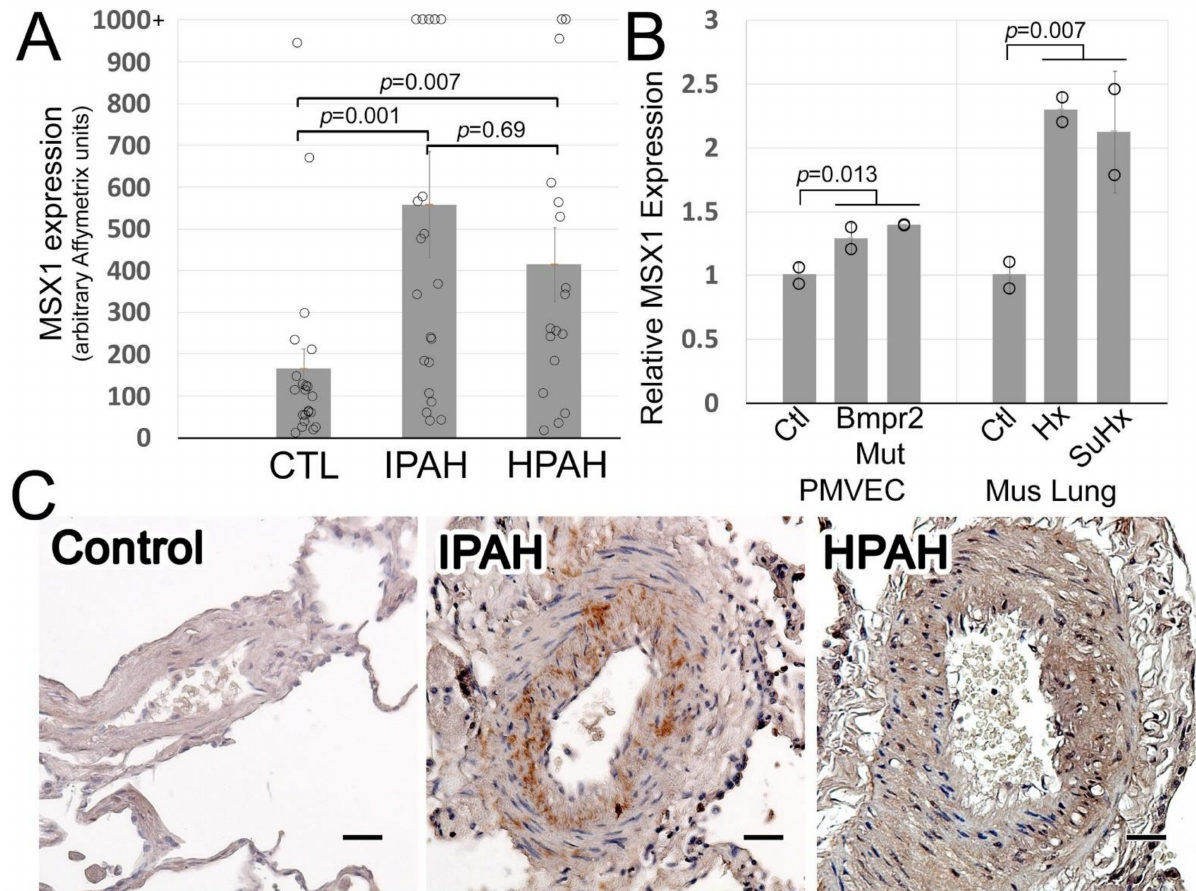
Figure 2. ( A ) MSX1 expression in lymphocytes cultured from control, IPAH, and HPAH patients; each circle is data from one patient, with averages and standard error of the mean indicated by grey bars with error bars. Significance shown was by ANOVA with post hoc tests on log-transformed data (required to satisfy normality). Significant differences were also p < 0.01 by Wilcoxon non-parametric test. ( B ) MSX1 is increased both by BMPR2 mutation in isolated pulmonary microvascular endothelial cells ( left ) and by either hypoxia or sugen-plus-hypoxia ( right ) in whole mouse lung. Mice were two sets of pooled RNA from both male and female mice (each circle represents 4 mice/pool). ( C ) MSX1 protein expression is increased in IPAH and HPAH pulmonary arteries. Intense brown color staining in pulmonary vessel cells as indicated by arrows in IPAH and HPAH patients ( n = 3). Magnification is 200 × . Scale bar = 50 µ